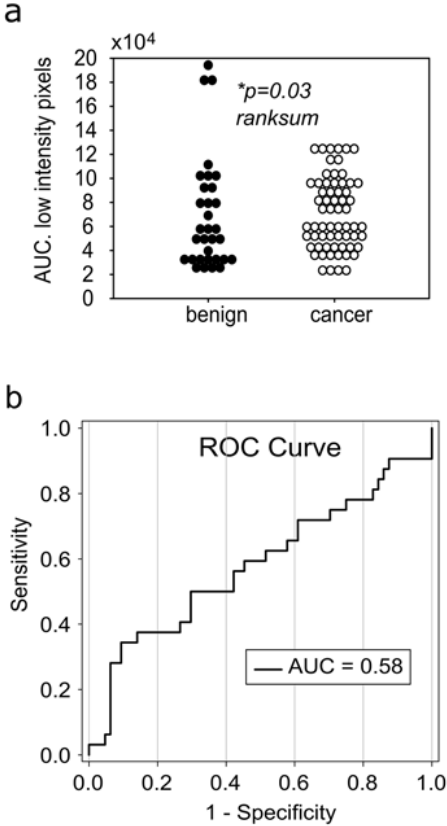
Figure 5. Receiver operating curves (ROC) of cool color histograms. ( a ) The best diagnostic accuracy was revealed for the decreased soft-tissue components (expressed as increased low intensity histogram bins) in malignant lesions, p = 0.03, rank sum test. ( b ) ROC shows a low diagnostic accuracy, Se = 0.3/Spe = 0.9, which is not sufficient as a standalone tool, but sheds light onto new image analysis aspects.